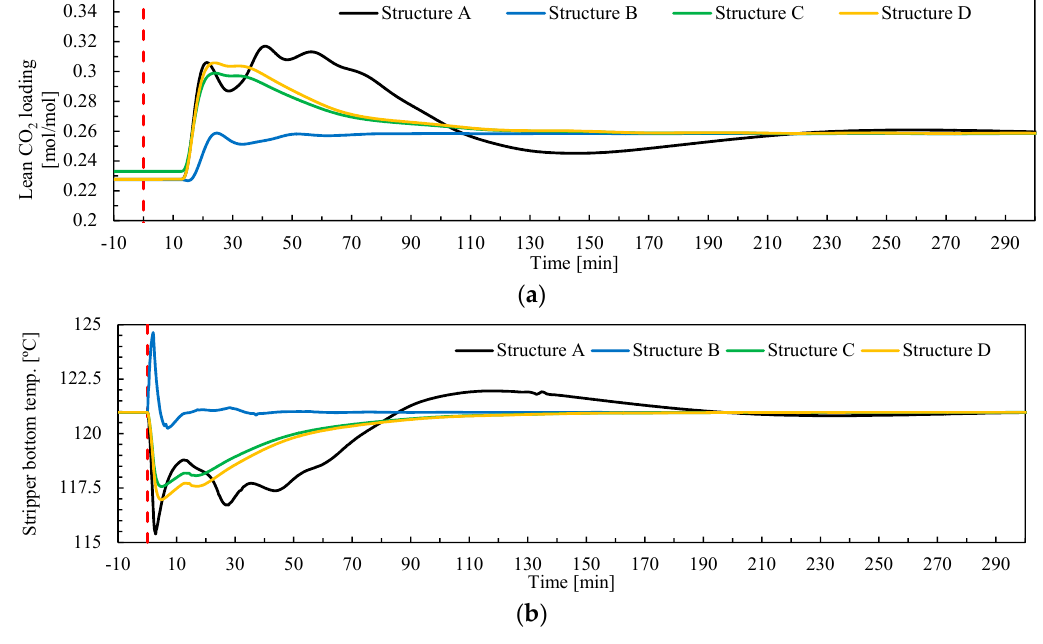
Figure 14. Outputs from pilot plant model during simulations for load change ramp-up (Test 2) from 70 to 100% with a ramp rate of 10%/min increase in flue gas flow rate, for control structures A, B, C and D. ( a ) Lean CO 2 loading at the inlet of the absorber; ( b ) Stripper bottom temperature as controlled variable ( ◦ C). The red vertical dotted line shows when the transient event starts at t 0